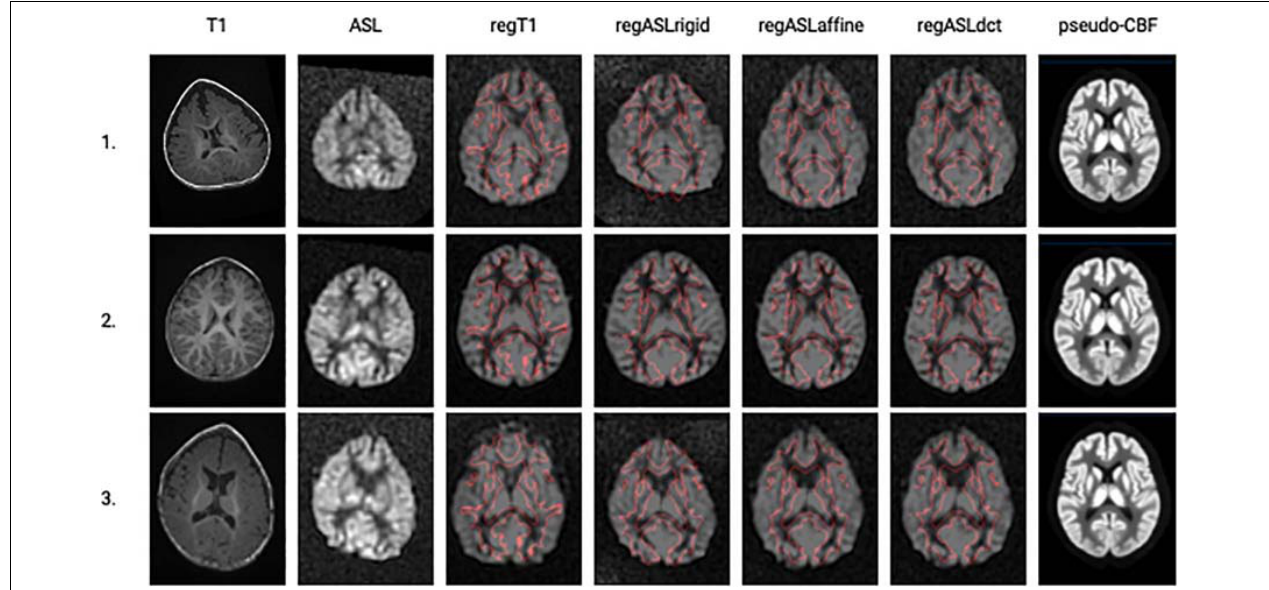
FIGURE 3 | A single axial slice is shown (columns left to right) for the T1-weighted image and the ASL image in their native space before registration and for the results of the four registration methods in the standard space: regT1, regASLrigid, regASLaffine, and regASLdct of three trigonocephaly subjects (rows). In the standard space, a CBF image is shown with borders of the WM from the template (with a threshold at 50%) shown in red. Finally, the pseudo-CBF images of the three trigonocephaly patients are shown.